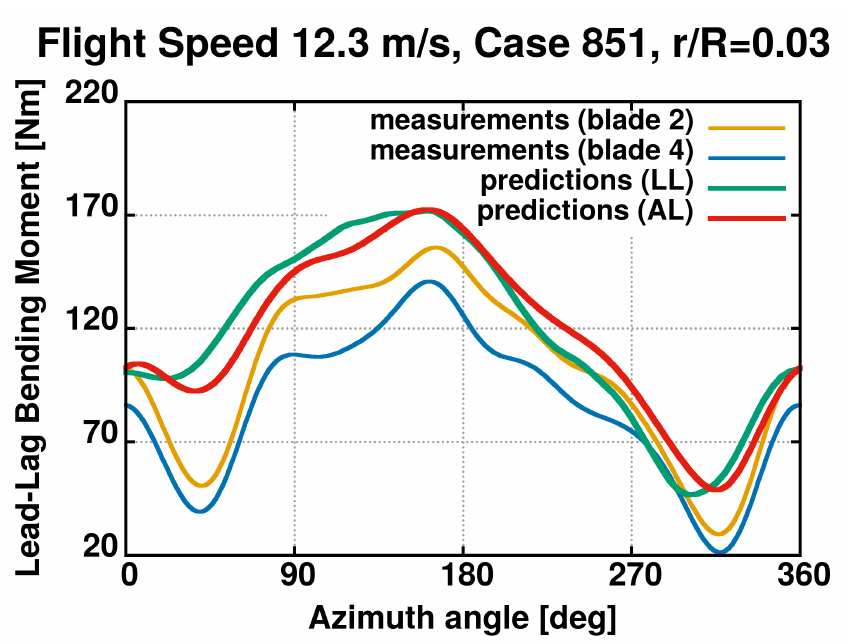
Figure 36. Forward flight at 12.3 m/s, case 851. Lead-lag moment at r / R = 0.03.